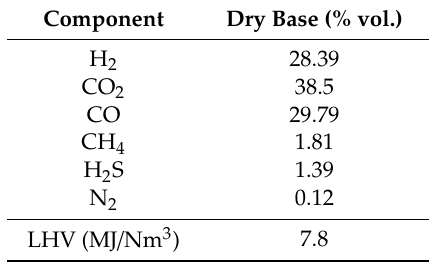
Table 3. Composition and lower heating value (LHV) of produced syngas in the Aspen Plus